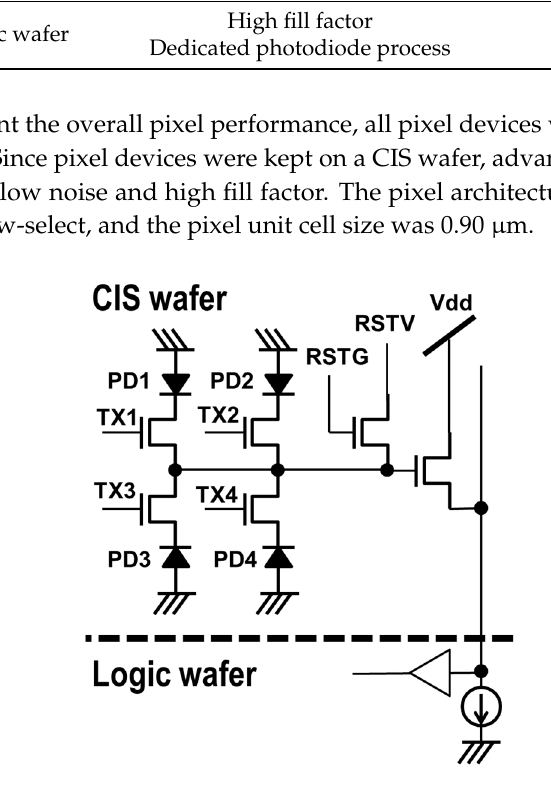
Figure 3. A unit pixel circuit and device partition.